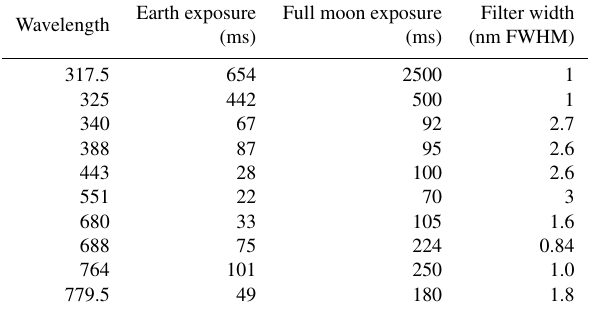
Table 1. Exposure Times for viewing the earth and full moon (earth side view)